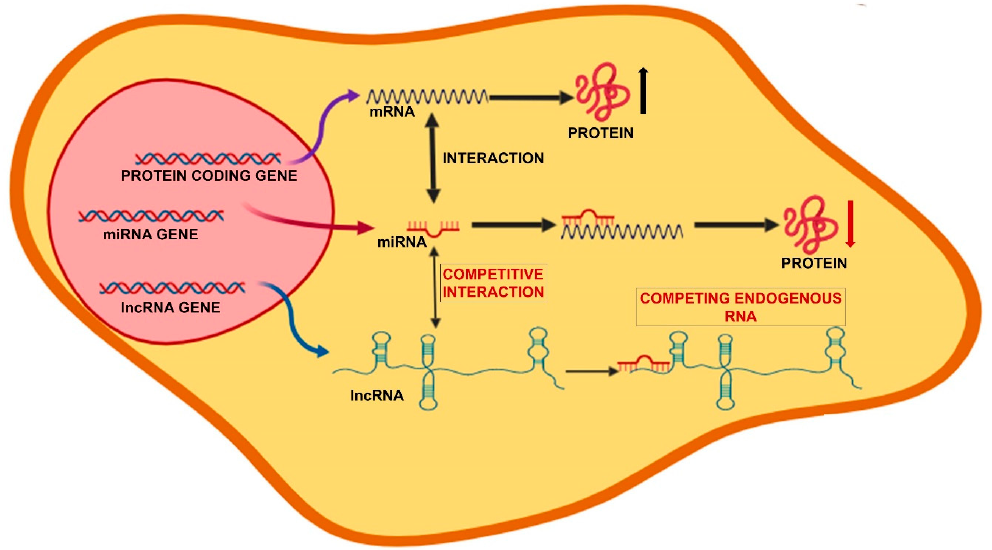
Figure 2. Competitive interactions between lncRNAs, miRNAs and mRNAs. The presence of miRNA response elements (MREs) allows the binding of miRNAs, which results in the inhibition of mRNA expression and / or stability. In addition, lncRNAs acting as ceRNAs harbor MREs and function as “sponges” for the miRNAs, which are sequestered so that the miRNA-RISC is unable to regulate the expression of target mRNAs. Thus, by acting as ceRNAs, lncRNAs are competitors for the binding of miRNA to the mRNA